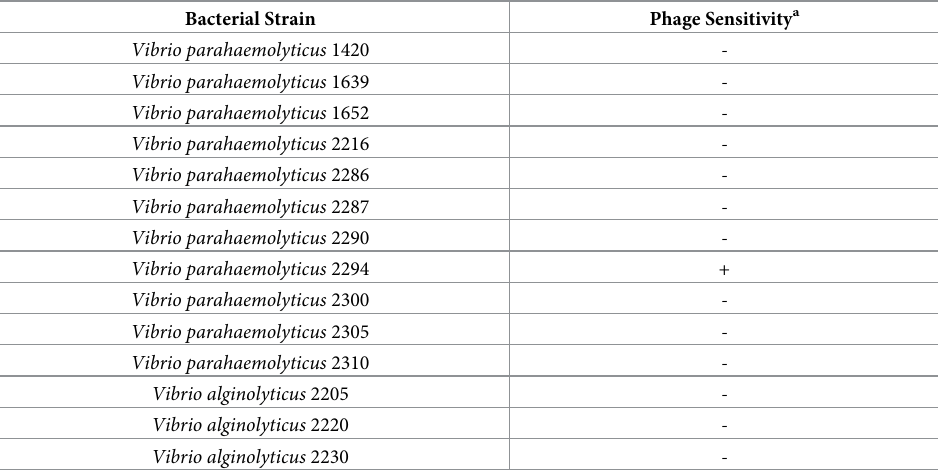
Table 1. Lytic activity of vB_VpS_PG28 against tested V . parahaemolyticus and V . alginolyticus